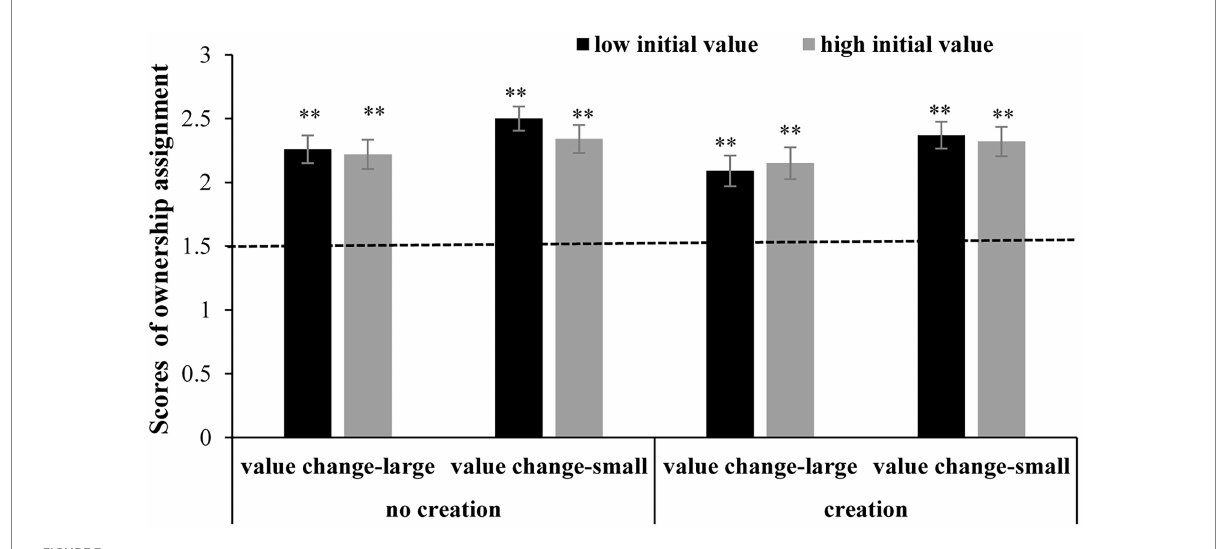
FIGURE 3 Subjects’ ownership scores in Study 3. Note: ** p <